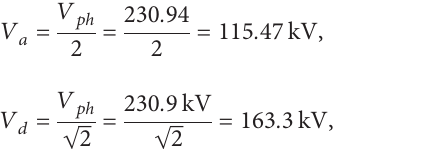
Figure 1: Power-angle